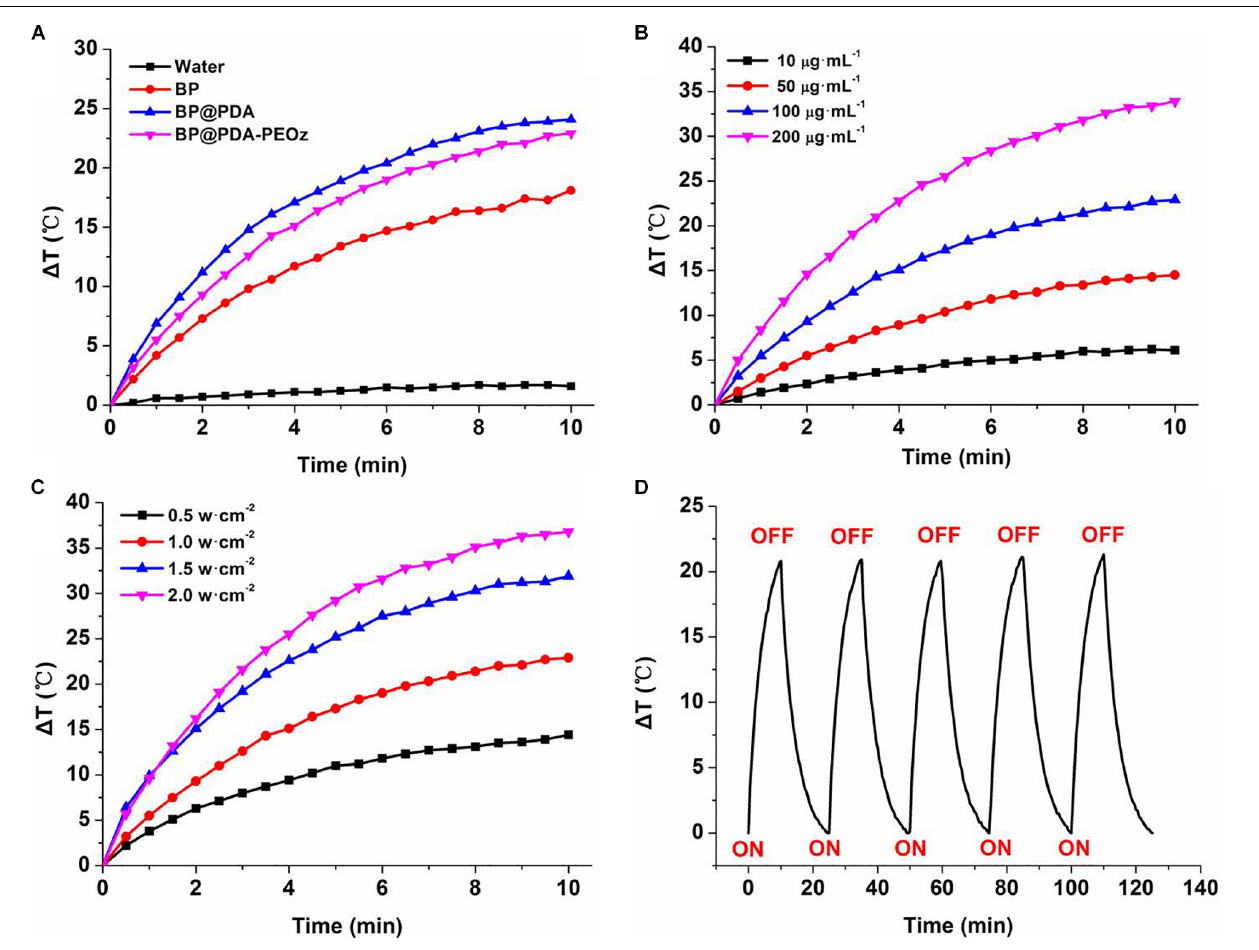
FIGURE 5 | (A) Photothermal heating curves of pure water, BP, BP@PDA, and BP@PDA-PEOz solution under 808 nm laser irradiation (1.0 W/cm − 2 ) for 10 min. (B) Photothermal heating curves of the BP@PDA-PEOz solution with different concentrations. (C) Photothermal heating curves of the BP@PDA-PEOz solution under various power intensities. (D) Heating of a suspension of the BP@PDA-PEOz in water for five laser on/off cycles with an 808 nm NIR laser at power density of 1.0 W/cm − 2